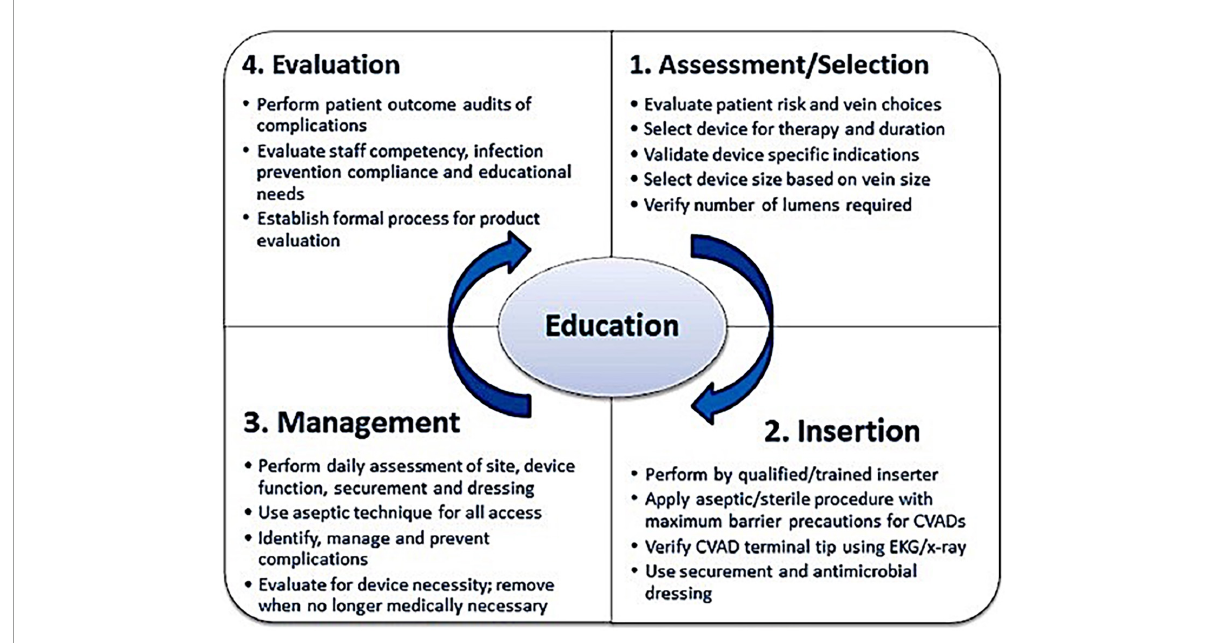
FIGURE1 Vessel health and preservation (VHP) model (21). Used with